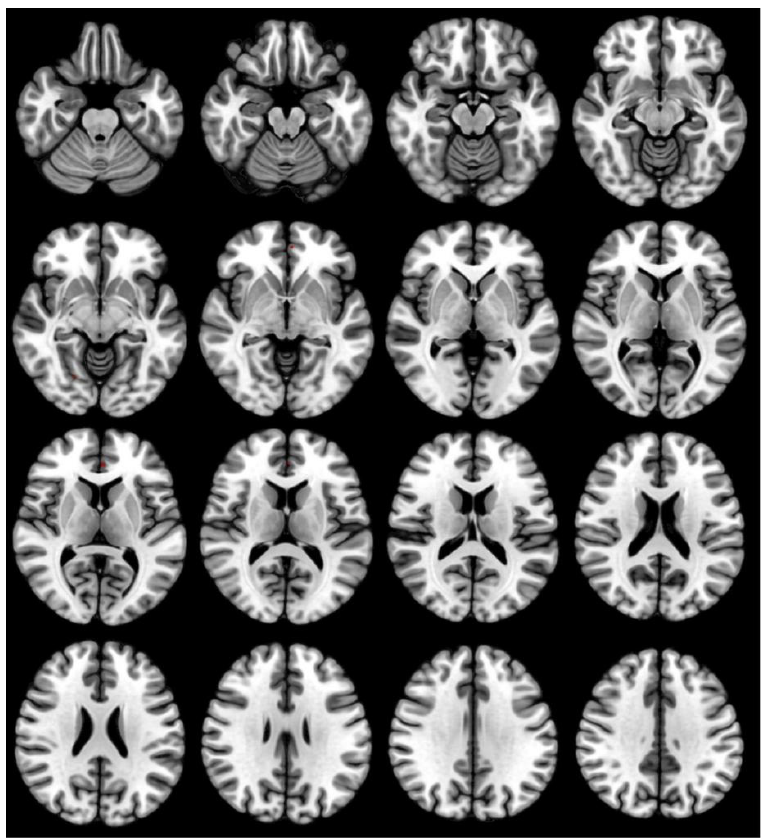
Figure 4. No significant changes in the GMV seen when comparing the RW and acute SD states (paired t -tests, voxel-level FWE, p < 0.05).